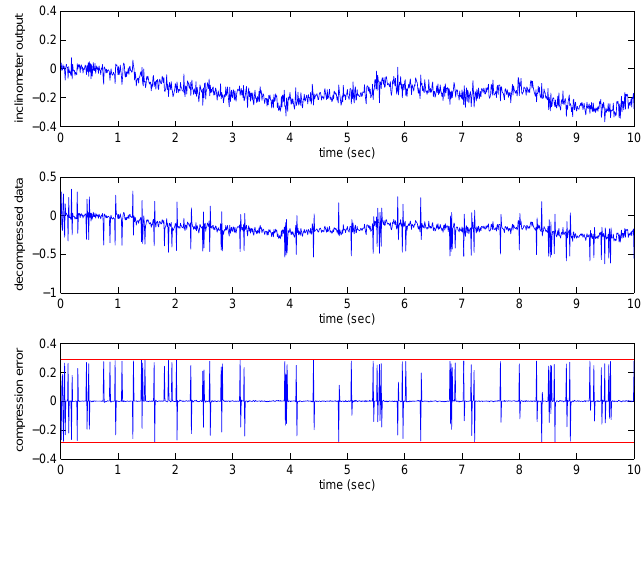
Figure 5. Inclinometer output, decompressed data, and error.